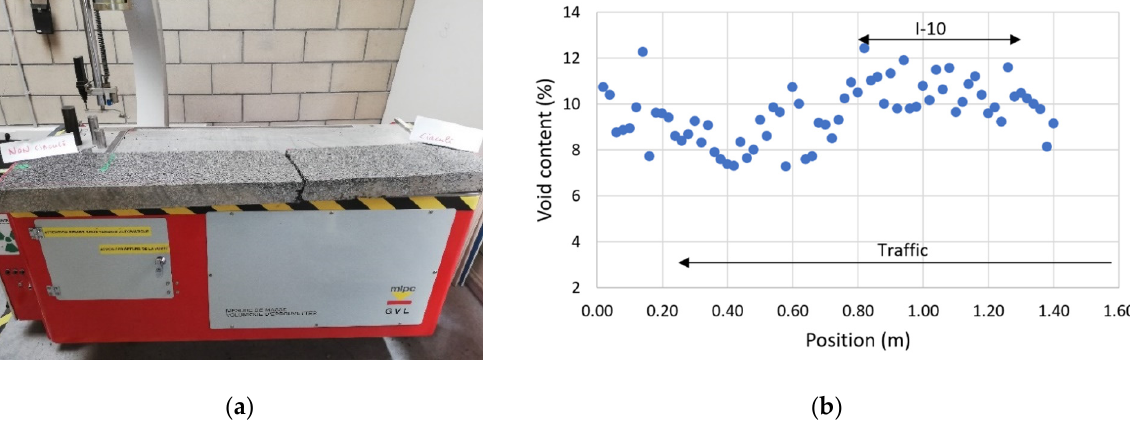
Figure 41. ( a ) Gammadensimetric acquisition on asphalt layer, ( b ) void content estimation vs. of lateral location.